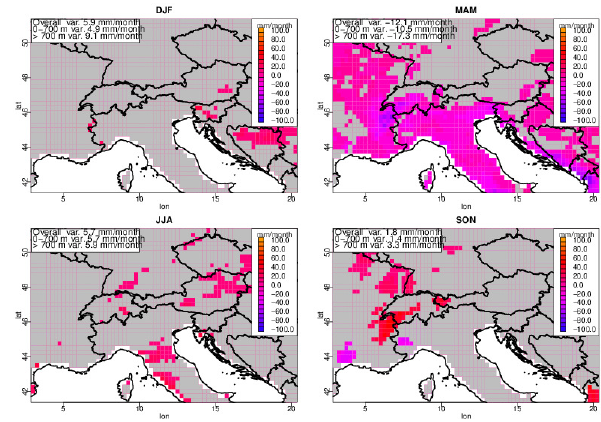
Figure 14: difference between the Multimodel SuperEnsemble scenario precipitation averaged over the period 2031-2050 with respect to the period 1981-2000, as a function of the season (T-test conf. level 95%) in the GAR area. Fig. 14. Difference between the multimodel superensemble sce- nario precipitation averaged over the period 2031–2050 with respect to the period 1981–2000, as a function of the season ( T test conf. level 95%) in the GAR